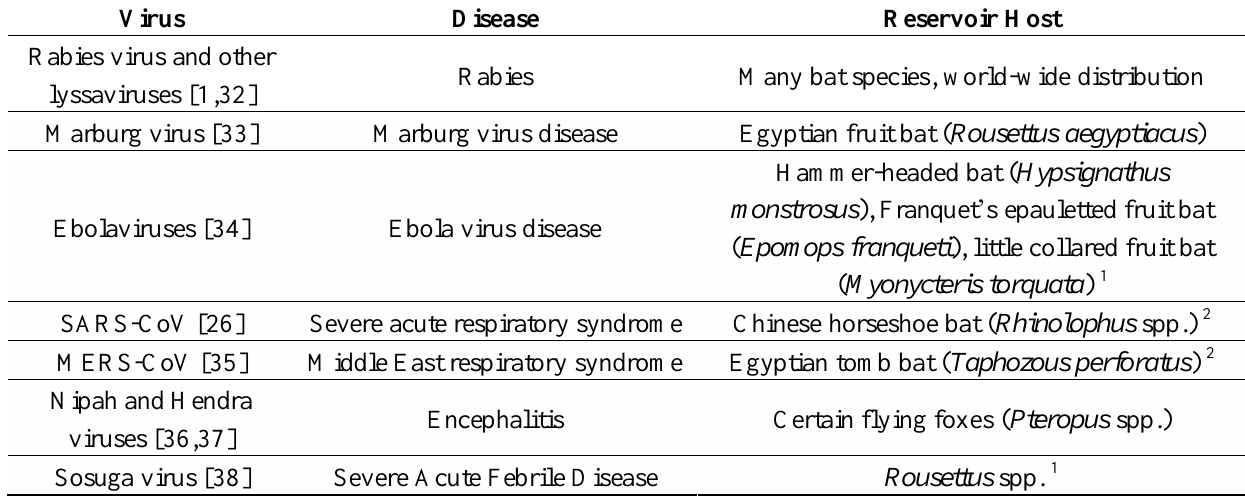
Table 1. High impact viruses and their (suspected) bat reservoir